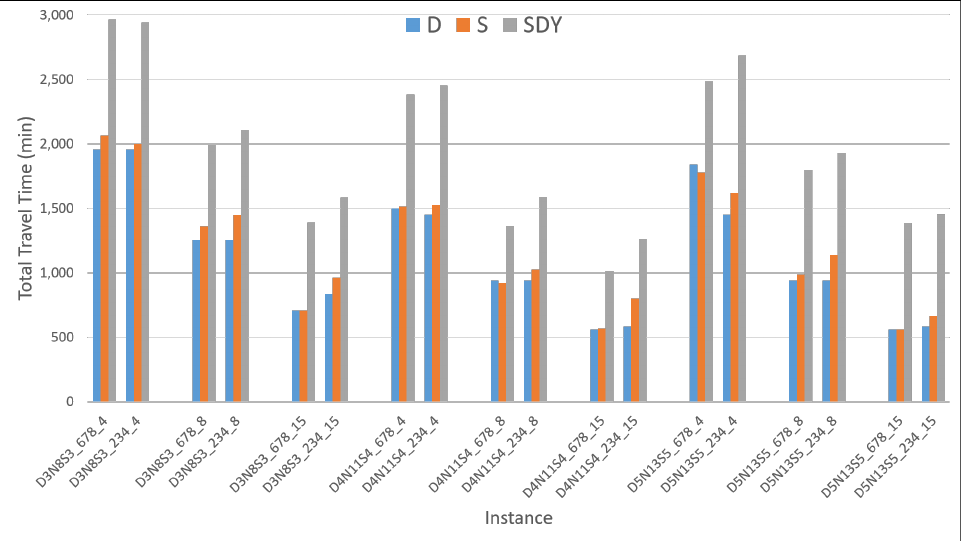
Figure A12. Total Travel Time: Offline and Online computation based on Model Characteristic and Maximum Road Capacity